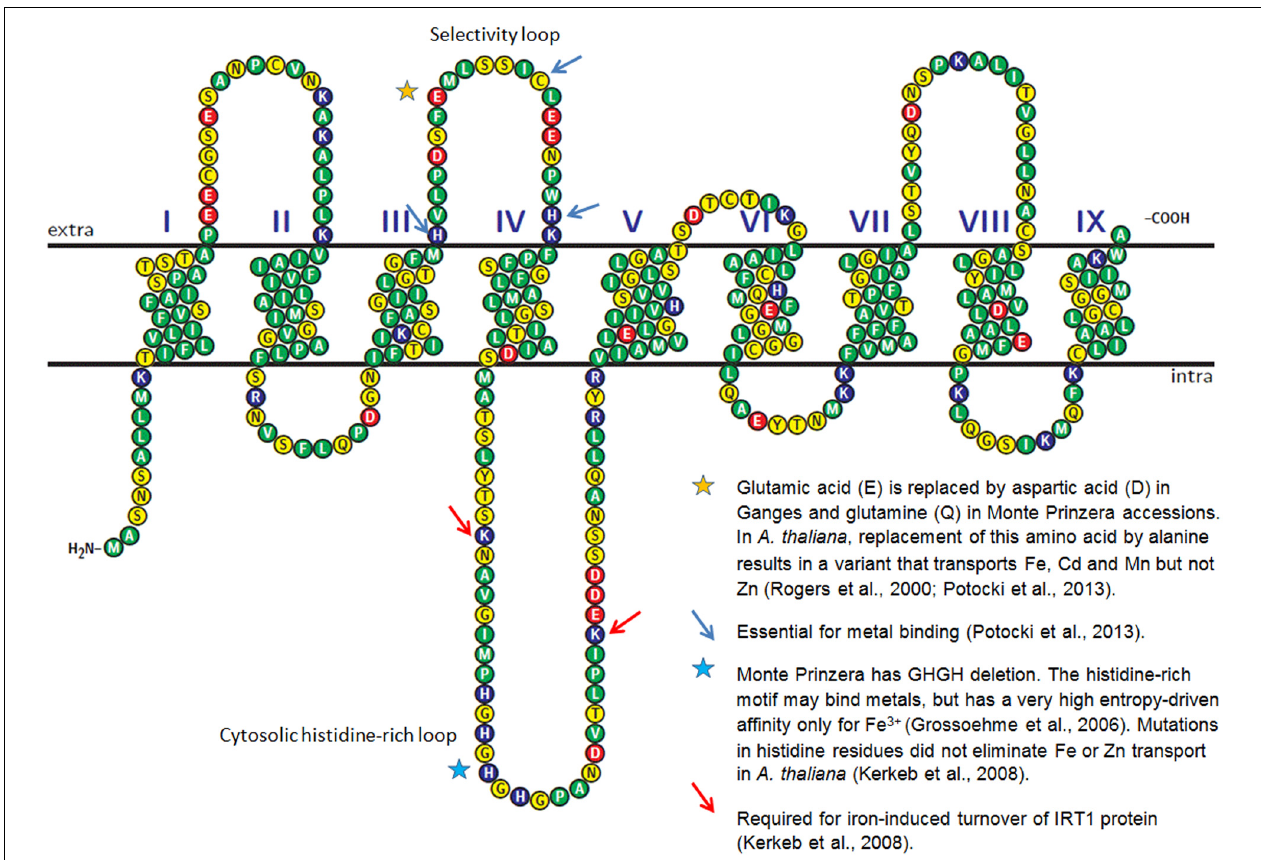
important for the function of IRT1 are labeled with stars and arrows. Stars also indicate the locations where N. caerulescens accessions differ from A. thaliana . The N. caerulescens amino acid sequences were derived from Illumina RNA-Seq analysis of three accessions: Lellingen, Ganges, and Monte